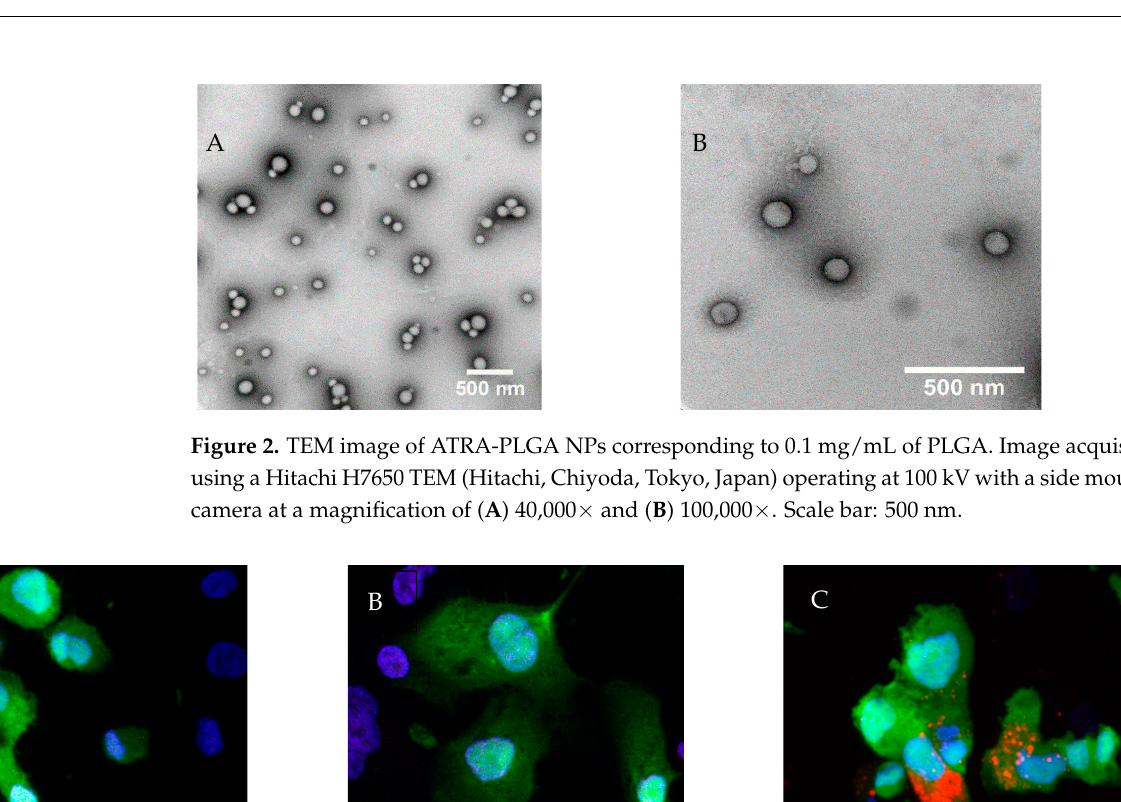
Figure 2. TEM image of ATRA-PLGA NPs corresponding to 0.1 mg/mL of PLGA. Image acquisition using a Hitachi H7650 TEM (Hitachi, Chiyoda, Tokyo, Japan) operating at 100 kV with a side mounted camera at a magnification of ( A ) 40,000× and ( B ) 100,000×. Scale bar: 500 nm.